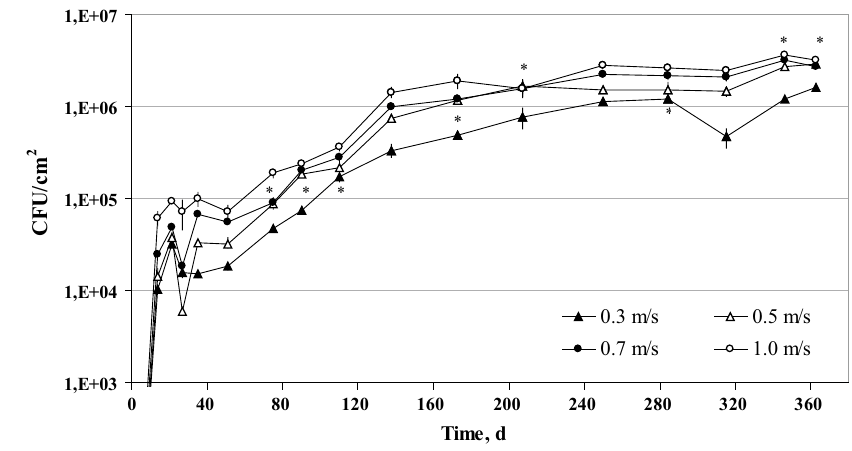
Fig. 2 Dynamics of the biofilm formation (measured as HPC density) under mean flow veloc- ities 0.3 m/s, 0.5 m/s, 0.7 m/s or 1 m/s in drinking water containing 0.05 ± 0.01 mg/l residual chlorine. The cultur- able bacteria number with 95% confidence intervals are plotted, number of analyses, n = 3÷6; the asterisk (*) indicates the insignificant difference between a pair of values compared by t -test (| t | < t 0.05; n